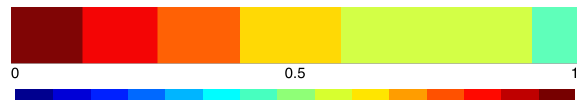
Figure 2. Concentration in the cylindrical pore.